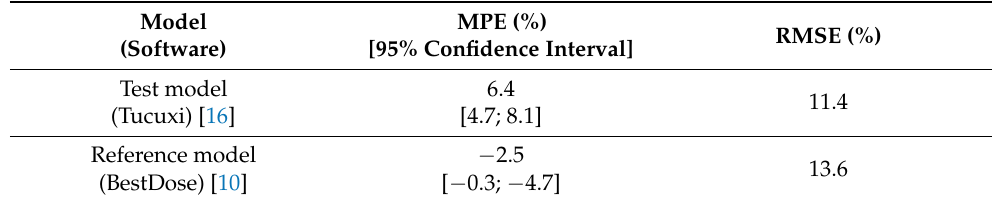
Table 3. Predictive performance of the test and reference model in the individual analysis of 61 pa- tients (119 measured